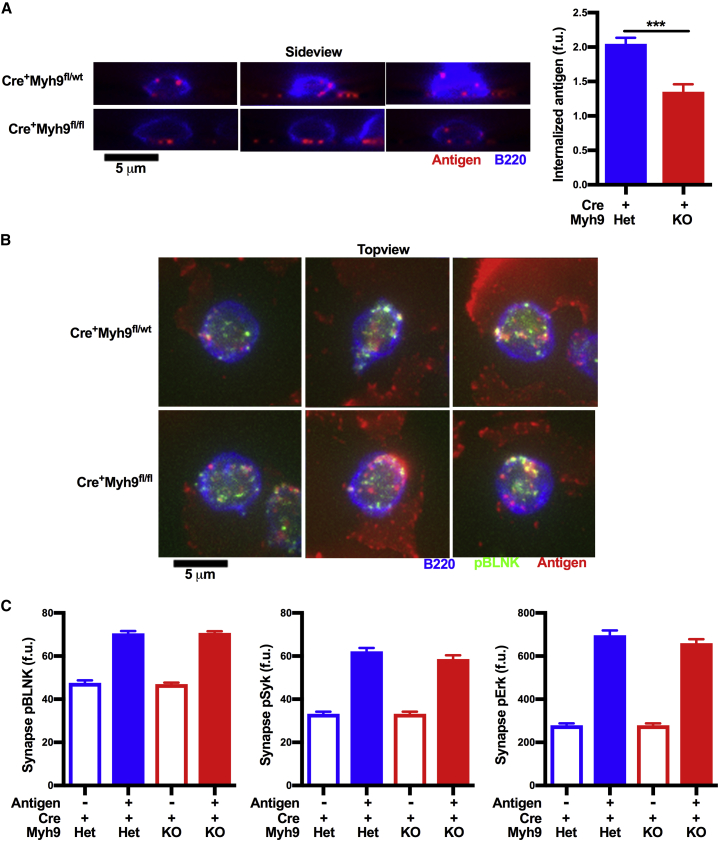
Myosin IIa-Deficient B Cells Are Less Efficient at Internalizing Membrane-Bound Antigen In Vitro(A) Side view reconstructions and quantification of internalized antigen of follicular B cells (blue) from CD23Cre+Myh9wt/fl and CD23Cre+Myh9fl/fl mice after 40 min of interaction with plasma membrane sheet (PMS)-bound antigen (red).(B) Top view of synapse plane showing pBlnk staining (green) in follicular B cells (blue) from CD23Cre+Myh9wt/fl and CD23Cre+Myh9fl/fl mice after 15 min of interaction with PMS-bound antigen (red).(C) Quantification of synaptic pBlnk (left), pSyk (middle), and pErk (right) after 20, 20, and 15 min of interaction with PMS, respectively. Cells that landed outside of PMS were used as unstimulated controls.Mean ± SEM (n > 192 cells). ∗∗∗p < 0.001 (Mann-Whitney U test). Fu, fluorescence units. See also Figure S5.